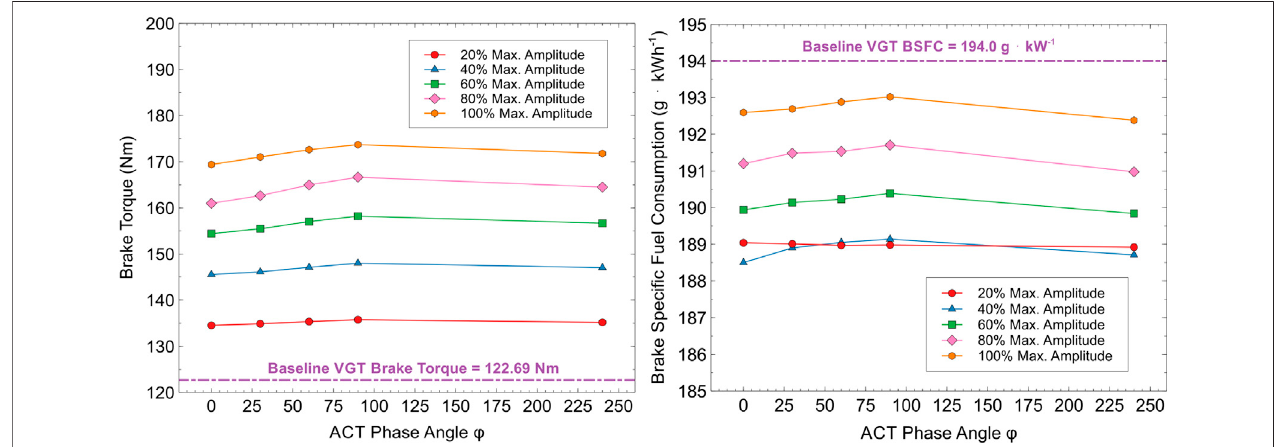
FIGURE 13 | Impact of amplitude ratio and phase angle on (left) : brake torque and (right) : brake speci fi c fuel consumption at cruise